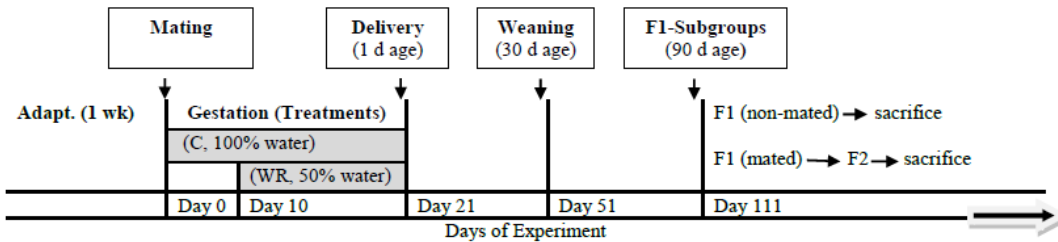
Figure 1. Experimental design.